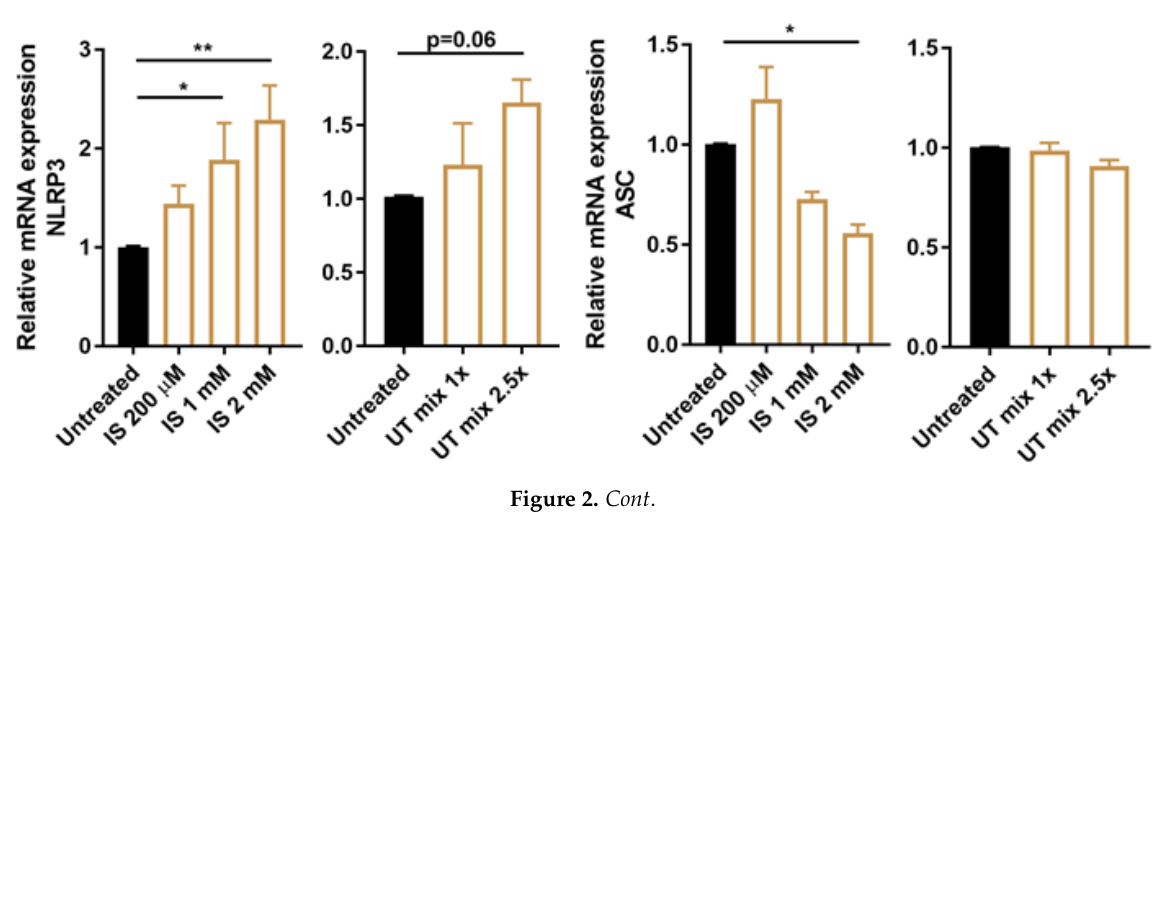
Figure 2. Expression of NLRP3 inflammasome related genes in ciPTEC-OAT1 after exposure to PBUTs. Relative mRNA expression of ( A ) NLRP3, ( B ) ASC, ( C ) caspase-1 and ( D ) IL-1 β upon exposure to either IS (200 μ M, 1 mM, 2 mM) or UT mix (1×, 2.5×), compared to control (untreated ciPTEC-OAT1). Data are derived from three independent experiments performed in duplicate and expressed as mean ± SEM. * p < 0.05, ** p < 0.01 (One-way ANOVA followed by Dunnett’s multiple comparison test, using untreated cells as a control). 3.3. PBUTs Induce Expression of NLRP3 Inflammasome-Related Proteins Following 24 h exposure to increasing concentrations of IS or UT mix, NLRP3 levels showed a dose-dependent increase at all tested concentrations (Figure 3A). Similar to what was observed for mRNA levels, ASC protein expression was downregulated in a dose-dependent manner after exposure to IS, while UT mix did not have a significant impact (Figure 3B). Treatment with LPS and ATP also did not significantly affect NLRP3 or ASC levels (Figure S1E,F). Caspase-1 activity was slightly increased after both IS and UT mix treatments at all concentrations evaluated, which was counteracted by ac-YVAD- cmk treatment (Figure 3C). One of the main indicators of inflammasome activation, IL-1 β secretion, was also increased at all concentrations of IS and UT mix tested, which was reduced in the presence of ac-YVAD-cmk (Figure 3D).